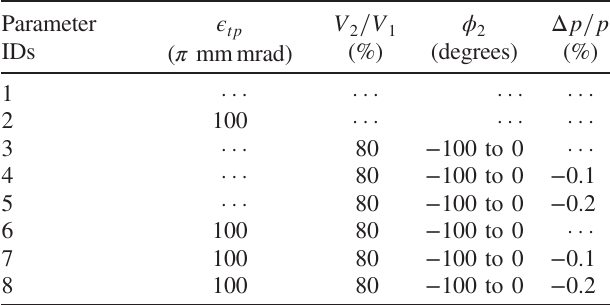
TABLE II. Injection painting parameters applied in the present beam experiment; (ID 1) no painting, (ID 2) transverse painting only, (IDs 3 – 5) longitudinal painting only, and (IDs 6 – 8) combinations of transverse and longitudinal